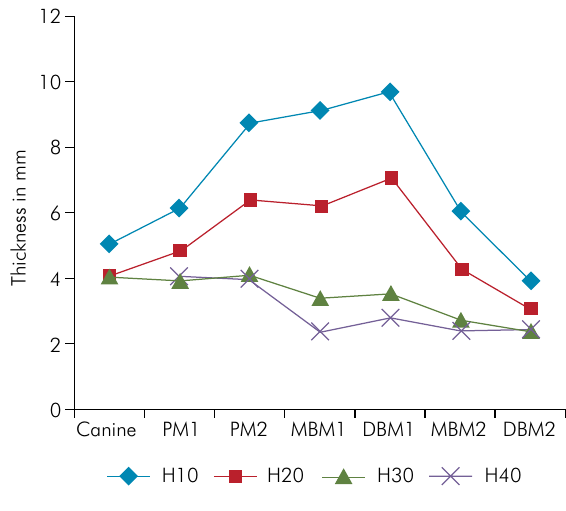
Figure 4. Line chart showing the distribution of lateral wall thickness at the intersection points between H10, H20, H30 and H40 and the axis of the canine, first premolar (PM1), second premolar (PM2), mesiobuccal & distobuccal roots of the first molar (MBM1 & DBM1) and mesiobuccal & distobuccal roots of the second molar (MBM2 & DBM2). Two distinct patterns can be observed, those at H10/H20 and those at H30/H40.